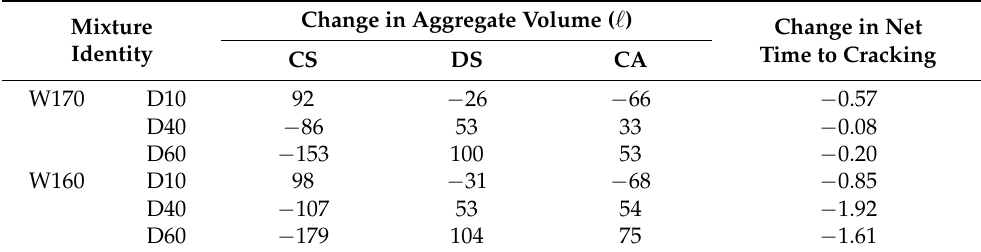
Table 5. Aggregate volume change and the change in net time to